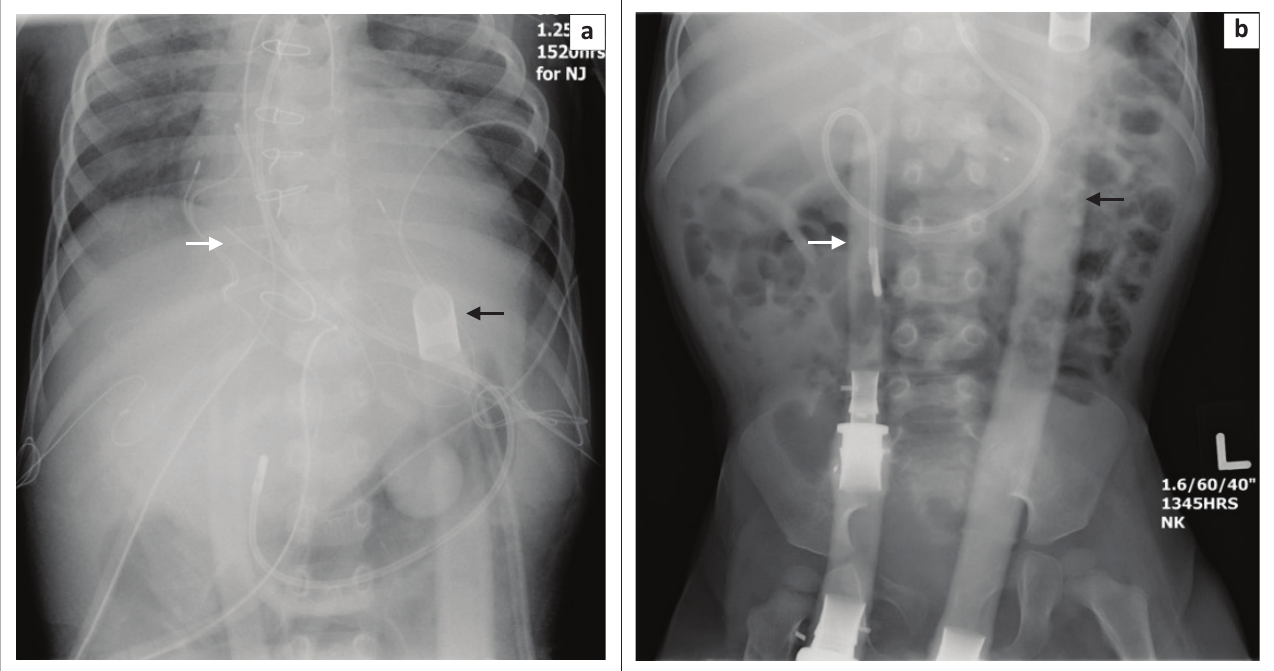
FIGURE 5: Chest (a) and abdominal (b) radiographs showing a Berlin Heart left ventricular assist device with its inflow (black arrow) and outflow (white arrow) cannulae implanted in the left ventricle and aorta, respectively, in a 2.5-year-old male child with severe left ventricular dysfunction following an episode of